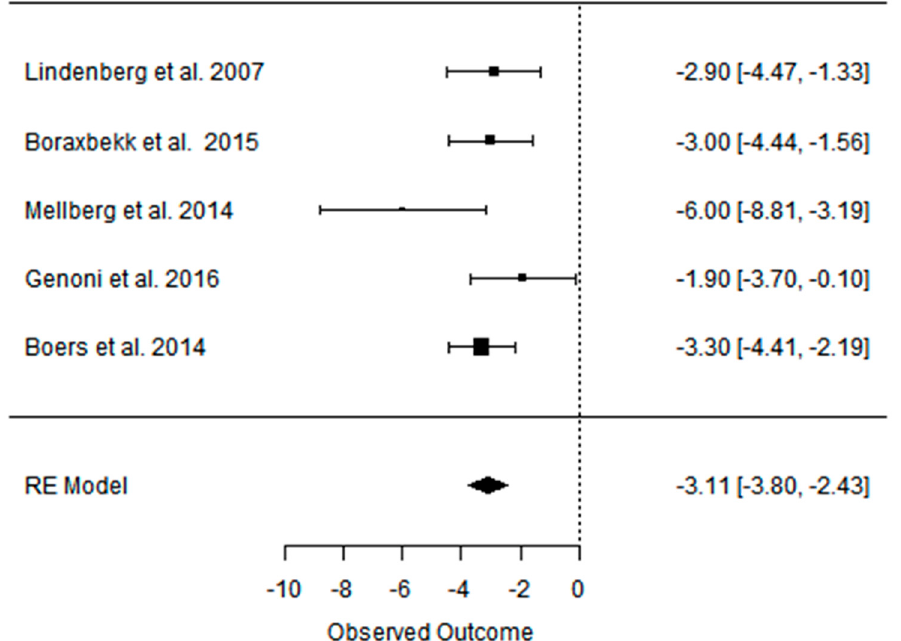
Figure A9. Forest plot of the effect of a CD on waist c (cm) in the short term (weighted mean difference).